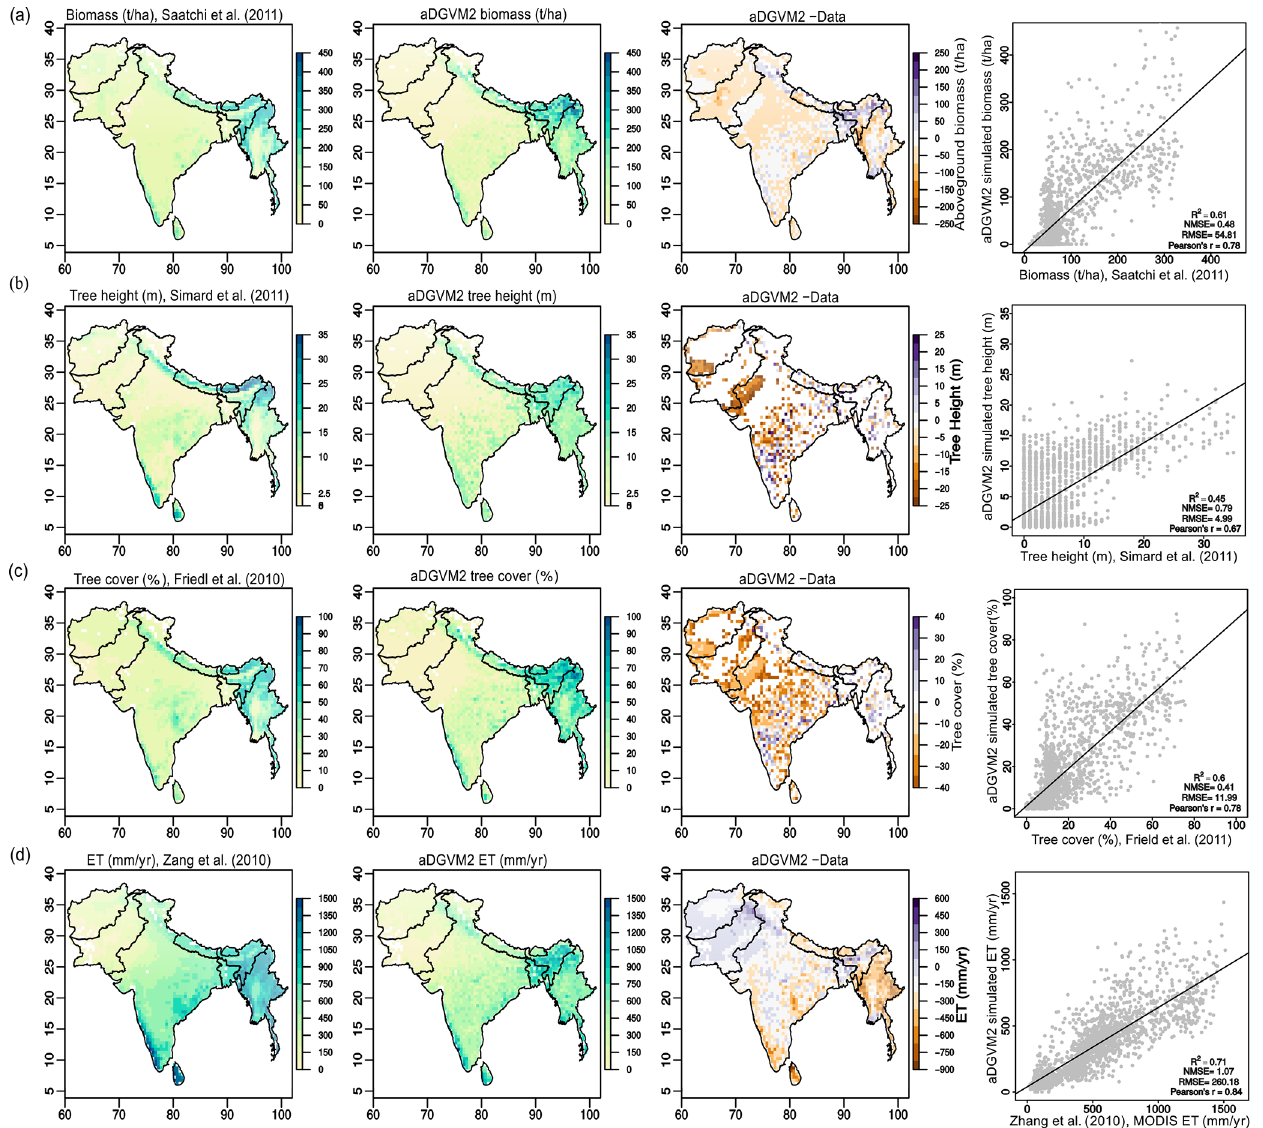
Figure 1. Comparison between aDGVM2 results and data for (a) simulated biomass and Saatchi et al. (2011) biomass, (b) simulated tree height and Simard et al. (2011) tree height, (c) simulated tree cover and Friedl et al. (2011) tree cover, and (d) simulated evapotranspiration and Zang et al. (2010) evapotranspiration. In the figure the first column shows the remote sensing products, the second column shows aDGVM2 results, the third column shows the difference between simulation and data, and the fourth column shows the scatter plot between simulated state variables against benchmarking data. NMSE and RMSE are the normalized mean square error and root mean square error, respectively. In the fourth column, each point represents one grid cell in the study region. For results with masked land-use cover see Supplement Fig.